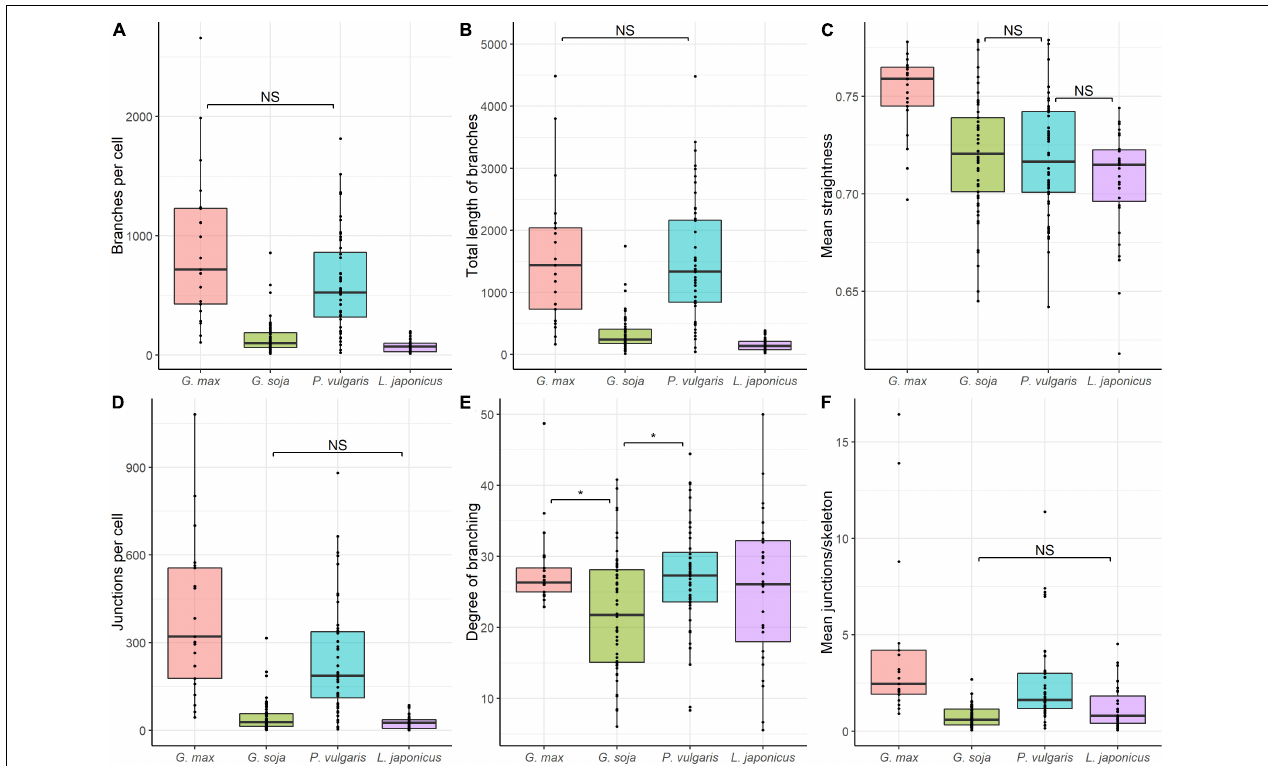
FIGURE 10 | Quantitative analysis of tubulin microtubule organization in nitrogen-fixing cells of G. max ( n = 21), G. soja ( n = 56), P. vulgaris ( n = 48), and L. japonicus ( n = 31) nodules. (A) Total number of branches per cell, number of all detected microtubules. (B) Total length of branches per cell, the total length of all detected microtubules per cell. (C) Mean straightness index of detected microtubules per cell, the Euclidian distance between the starting and ending point of each branch divided by its full length. (D) Total number of junctions per cell. (E) Degree of branching per cell, number of skeletons (sets of branches, connected together) with more than one branch divided by the total number of skeletons in the image. (F) Mean number of junctions per skeleton, average number of branching points across all skeletons in the cell. Dots indicate analyzed images of individual cells. Pairwise comparisons were conducted using Tukey’s range test, NS indicates not significant differences ( p > 0.05), otherwise differences are significant ( p < 0.05).